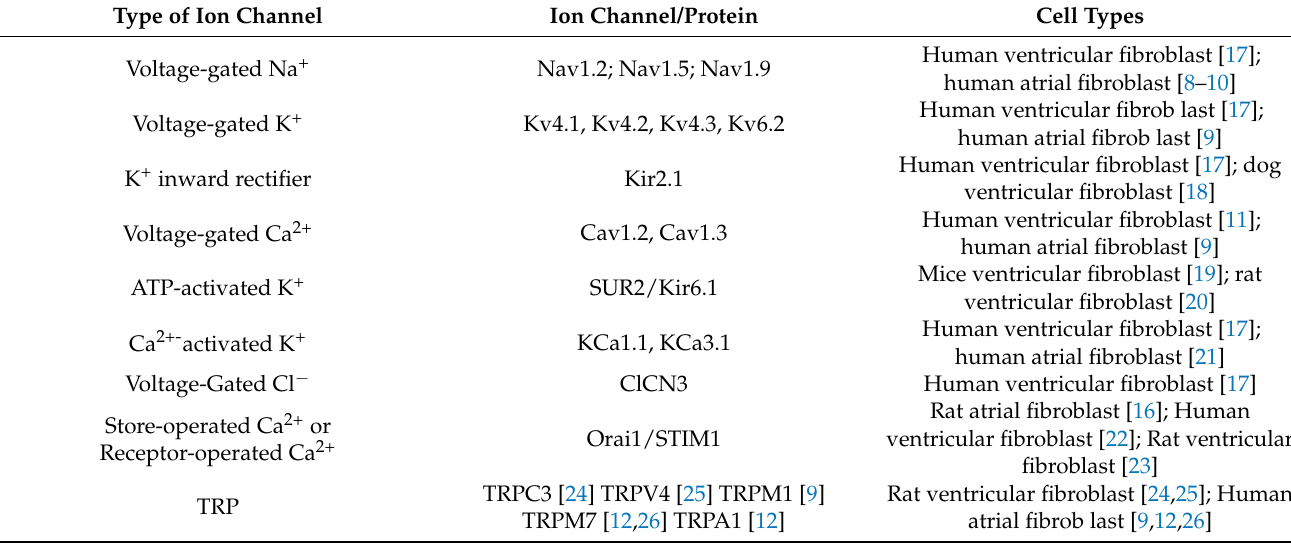
Table 1. Reported cardiac myo-/fibroblast ion channels from different locations and